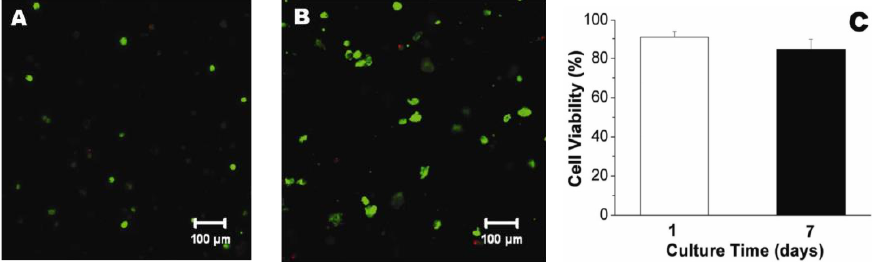
Figure 15. Live/Dead assay for encapsulated SMCs within Alg/Gel hydrogel discs, ( A ) after 1 day and ( B ) after 7 days. ( C ) Cell viability measured based on Live/Dead images. Adapted with permission from ref. [133]. Copyright 2012, Wiley Periodicals.